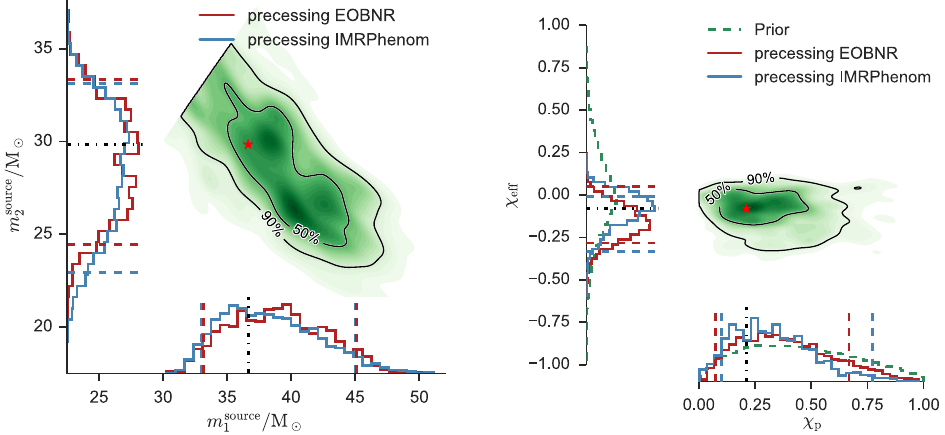
FIG. 8. Posterior probability densities for the source-frame component masses m source 1 and m source 2 , where m source 2 ≤ m source 1 (left panel) and effective aligned χ and effective precessing spins χ (right panel) for an eventlike NR mock signal close to MaP parameters. In the eff p one-dimensional marginalized distributions, we show the precessing EOBNR (red) and precessing IMRPhenom (blue) probability densities with dashed vertical lines marking 90% credible intervals. The two-dimensional plot shows the contours of the 50% and 90% credible regions of the precessing EOBNR over a color-coded posterior density function. The true parameter values are indicated by a red asterisk or black dot-dashed